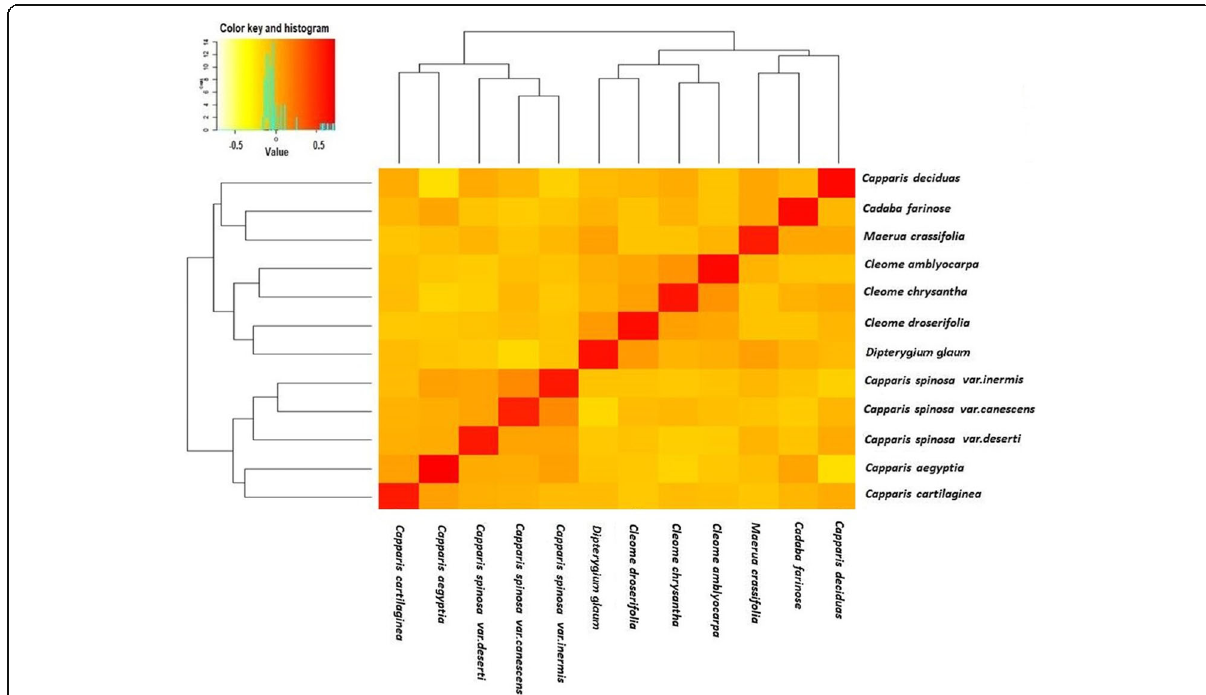
Fig. 7 Heatmap cluster analysis (HCA) signatures among 12 Capparaceae species using ISTR profiles. Subclades are highlighted by a colorful background; the scale bar showed on the top illustrates the relative genetic variability from 0.5 to −